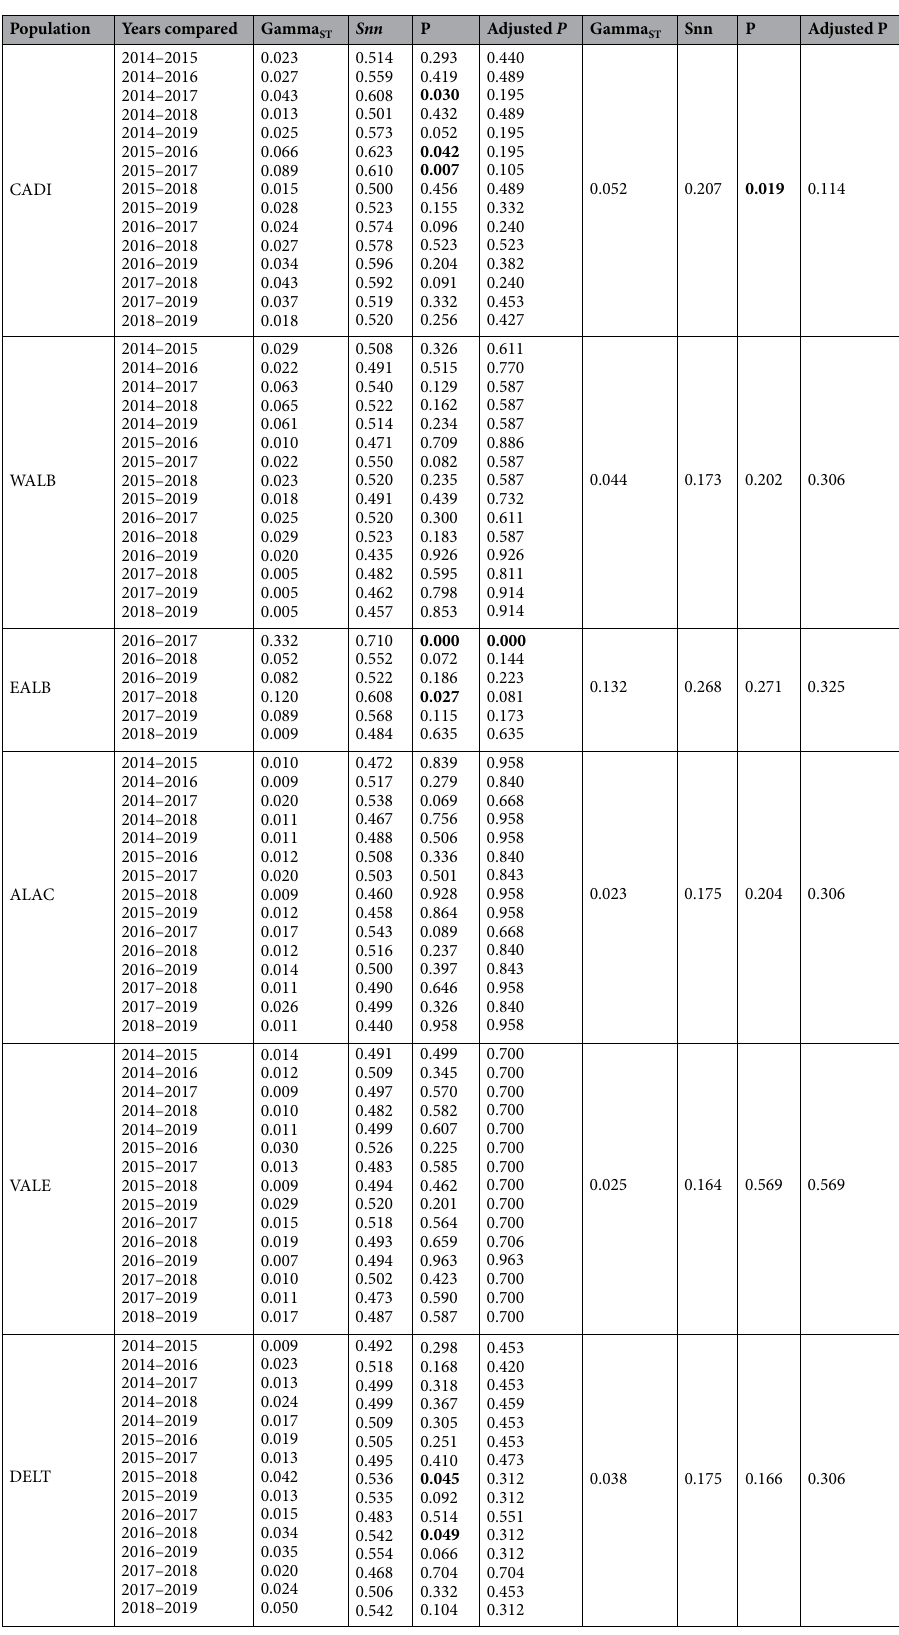
Table 2. Gamma ST and Snn values with the corresponding P values computed in each population for each pair of consecutive years. The population acronyms are the same as those presented in Table 1. Significant P values appear in